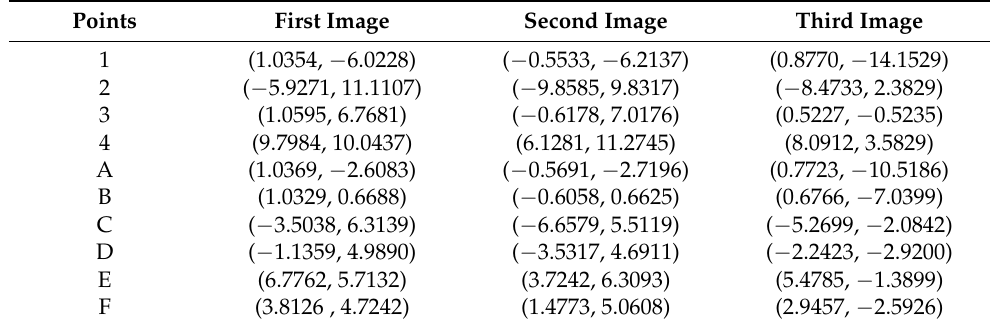
Table 3. Image plane coordinates of the three images.